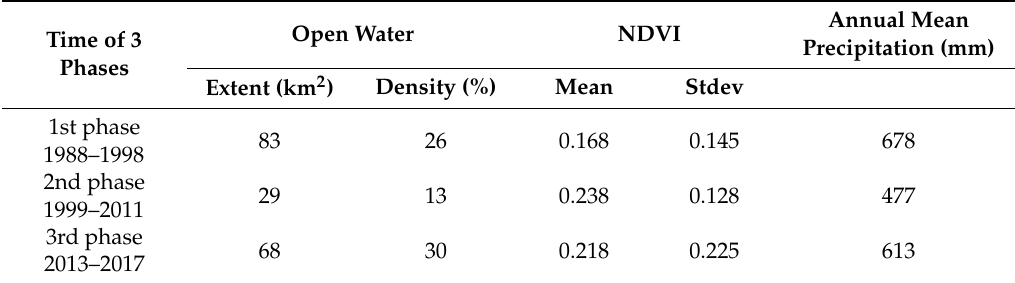
Figure 10. The density images of open water in the three phases as for ( a ) left column is the first phase of 1988–1998, ( b ) middle column is the second phase of 1999–2011, ( c ) right column is the third phase of 2013–2017, which are derived from extracted open water data using 190 Landsat scenes. Table 2. The averaged open water extents, and density of open water and NDVI across the whole of wetland in 2017 and annual mean precipitation in the three